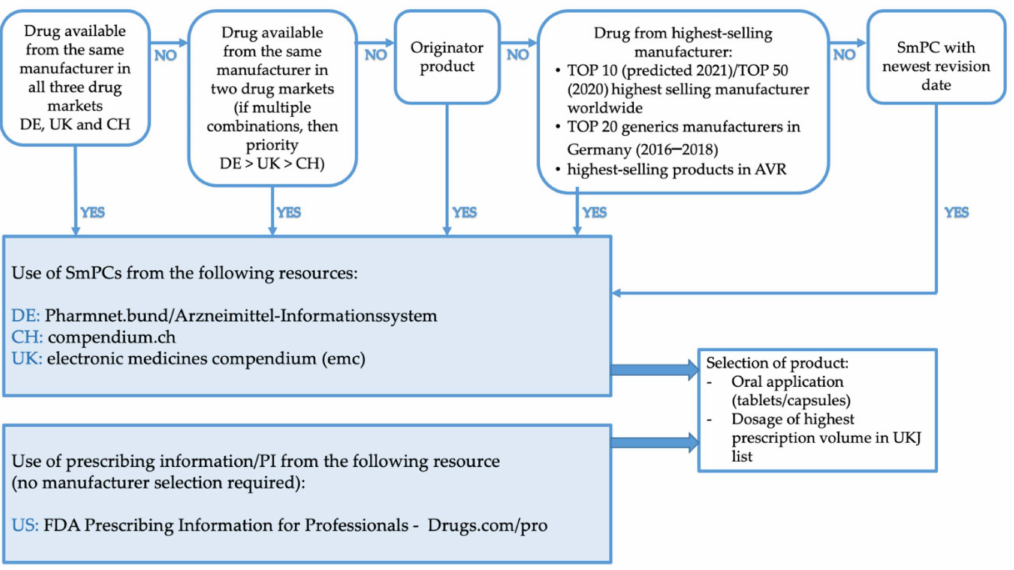
Figure 2. Selection of SmPCs/PI for analysis. References: TOP 10 (predicted 2021) [24], TOP 50 (2020) [25], TOP 20 generics manufacturers in Germany (2016–2018) [26], AVR